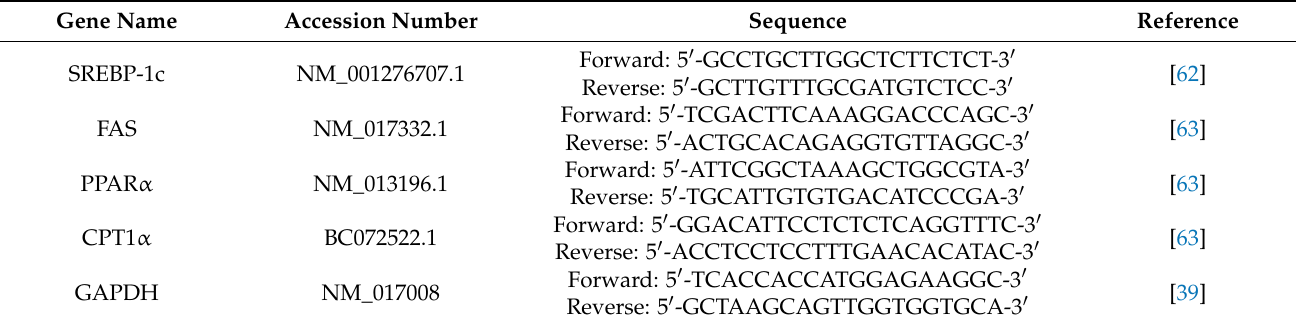
Table 1. Primers used for PCR